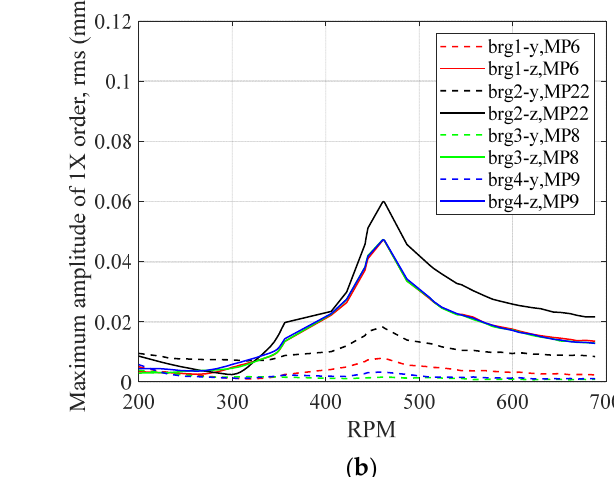
Figure 12. First order tracking of response, ( a ) measurement data test-b, ( b ) test-a.